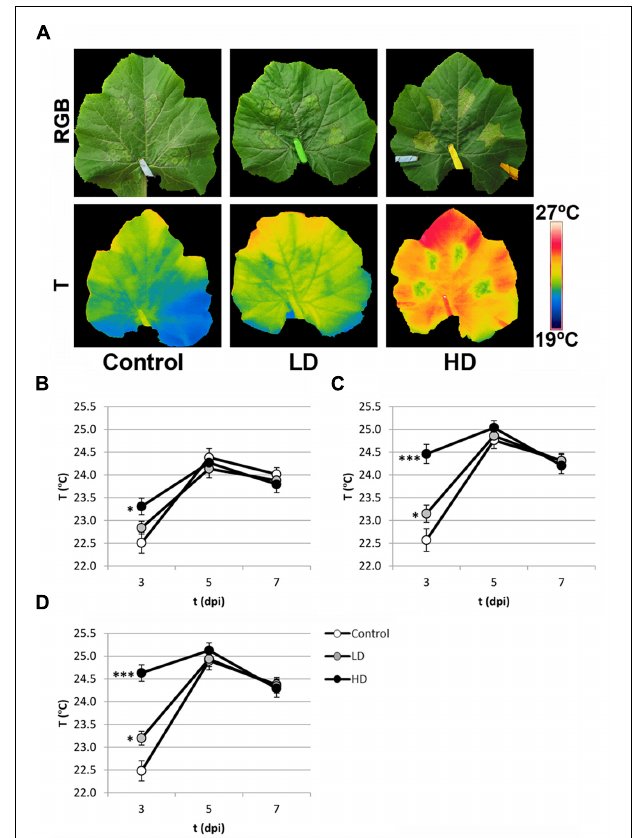
FIGURE 2 | (A) Standard F440/F520 images of mock-control, LD, and HD-inoculated zucchini leaves at 3 dpi, and their corresponding RGB images. Progression of F440/F520 signal in I (B) , N (C) , and D (D) areas of the leaves along the period of study. Symbols ∗ , ∗∗ , and ∗∗∗ stand for p < 0.1, 0.01, and 0.001, respectively.